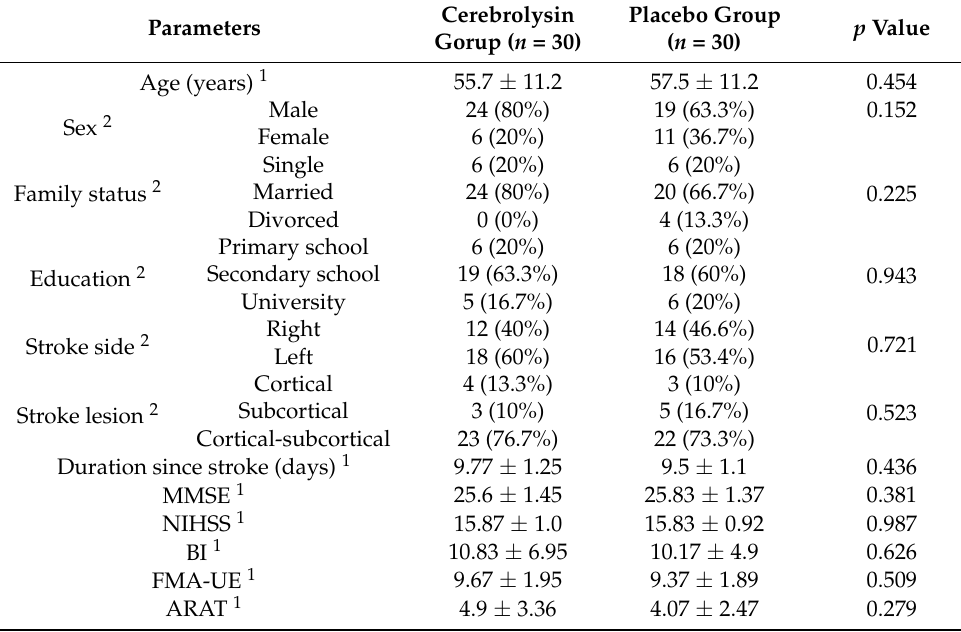
Table 1. Descriptive statistics of basic characteristics.